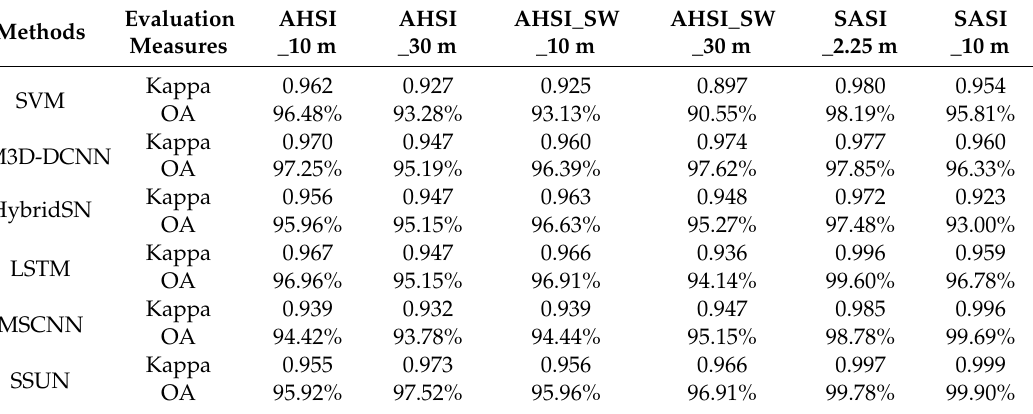
Table 8. Classification accuracy values for all